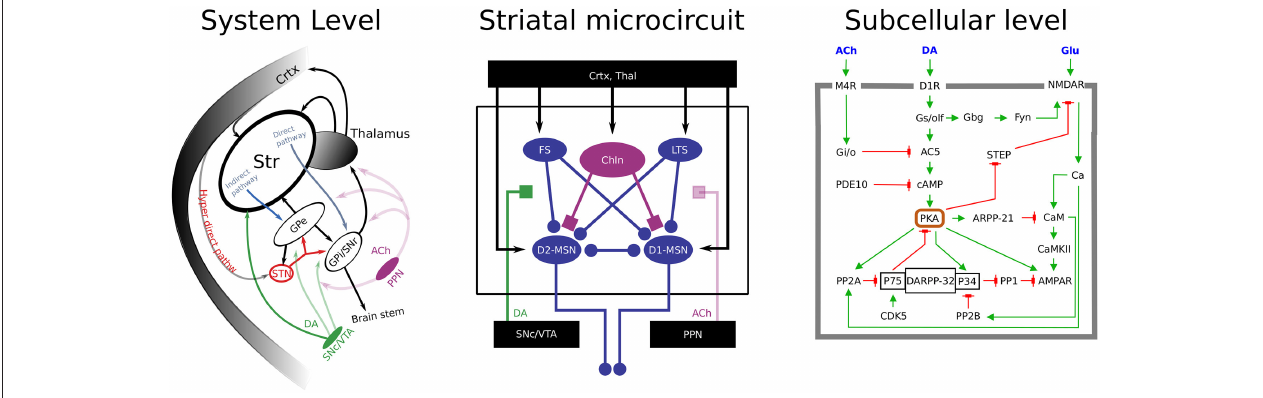
FIGURE 1 | A multi-scale view of basal ganglia. (Left) an illustration of the basal ganglia macro-circuitry, showing the glutamatergic and dopaminergic afferent inputs to striatum, as well as the projections via the direct and indirect pathways. Ca 50% of MSNs belong to the direct pathways, they carry dopamine type 1 receptors and project to GPi/SNr (D1-MSN). The other MSNs express dopamine type 2 receptors and project to GPe (globus pallidus externa) before reaching basal ganglia output structures (D2-MSN). At rest these output structure neurons keep motor programs in the brain stem and thalamus under tonic inhibition. When e.g., direct pathway GABAergic MSNs in the striatum become active they inhibit these tonically active neurons, and thereby the inhibition from basal ganglia onto the action/motor centers is relieved. This is the basis for the classical model of basal ganglia function in selection of (motor) actions. (Middle) a schematic representation of the striatal micro-circuitry. The main neuron type in the striatum is the medium spiny neuron (MSN), constituting ∼ 95% of striatal neurons. MSNs are the projection neurons from the striatum and receive convergent excitatory glutamatergic input from cortex and thalamus, inhibitory GABAergic input from neighboring MSNs and striatal fast-spiking (FS) and low-threshold spiking (LTS) neurons, cholinergic (ACh) input from cholinergic interneurons (ChINs) and pedunculopontine nucleus (PPN), and dopaminergic input from substantia nigra compacta (SNc). (Right) Examples of receptor induces cascades involved in controlling LTP in the cortico-striatal